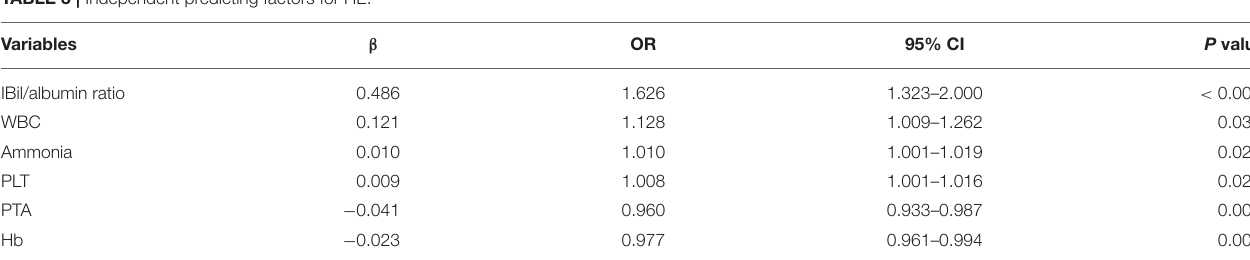
TABLE 3 | Independent predicting factors for HE.